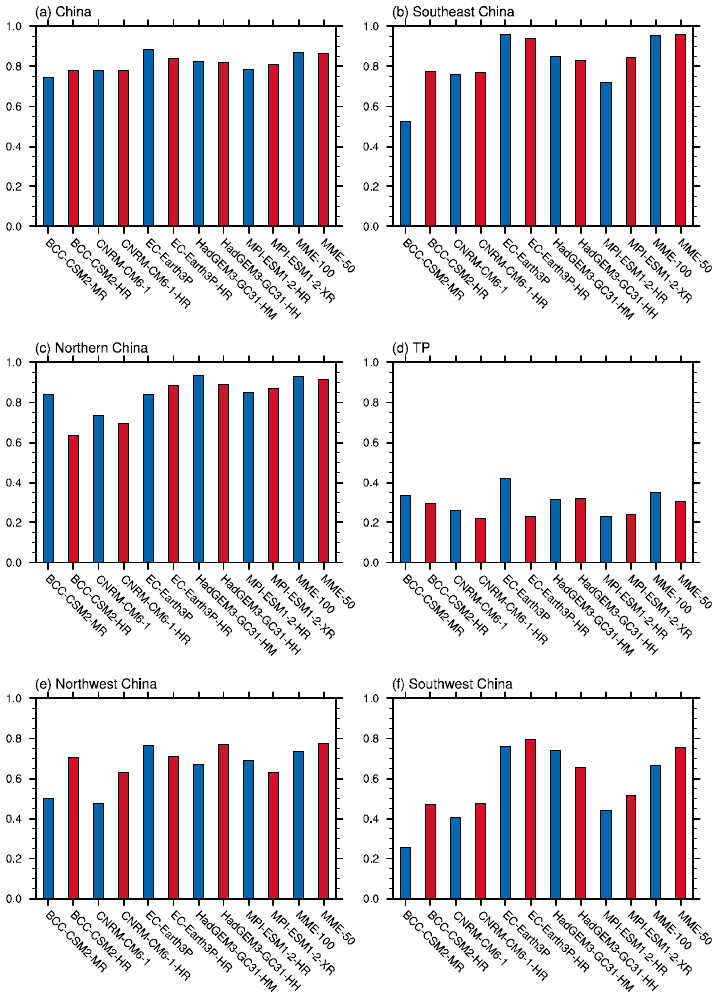
Figure 4. Skill scores of the precipitation over ( a ) China, ( b ) Southeast China, ( c ) Northern China, ( d ) TP, ( e ) Northwest China, and ( f ) Southwest China are simulated by the models. In Northwest China, three of the five high-resolution models improve their skill scores in simulating the precipitation relative to the corresponding lower-resolution